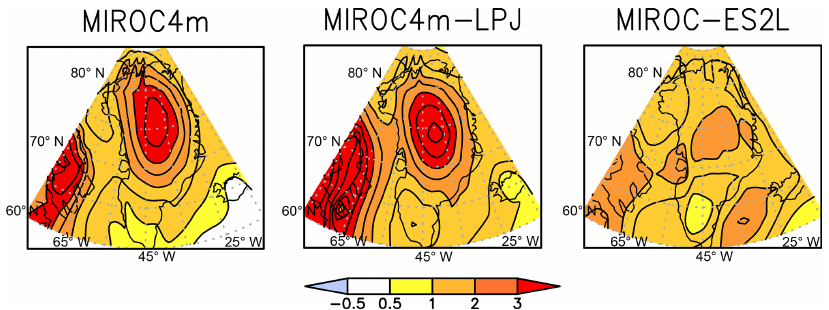
Figure 5. May–June–July–August averaged temperature difference (K) between 127k and PI in three models. The calendar for 127k is adjusted using a method based on Bartlein and Shafer